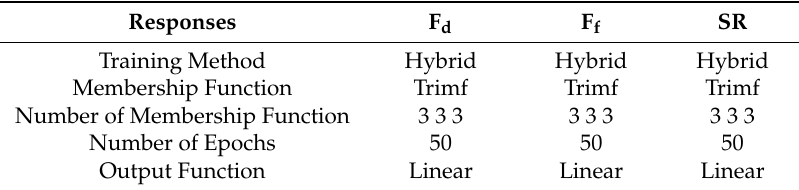
Table 7. Initial parameters for designing ANFIS models.